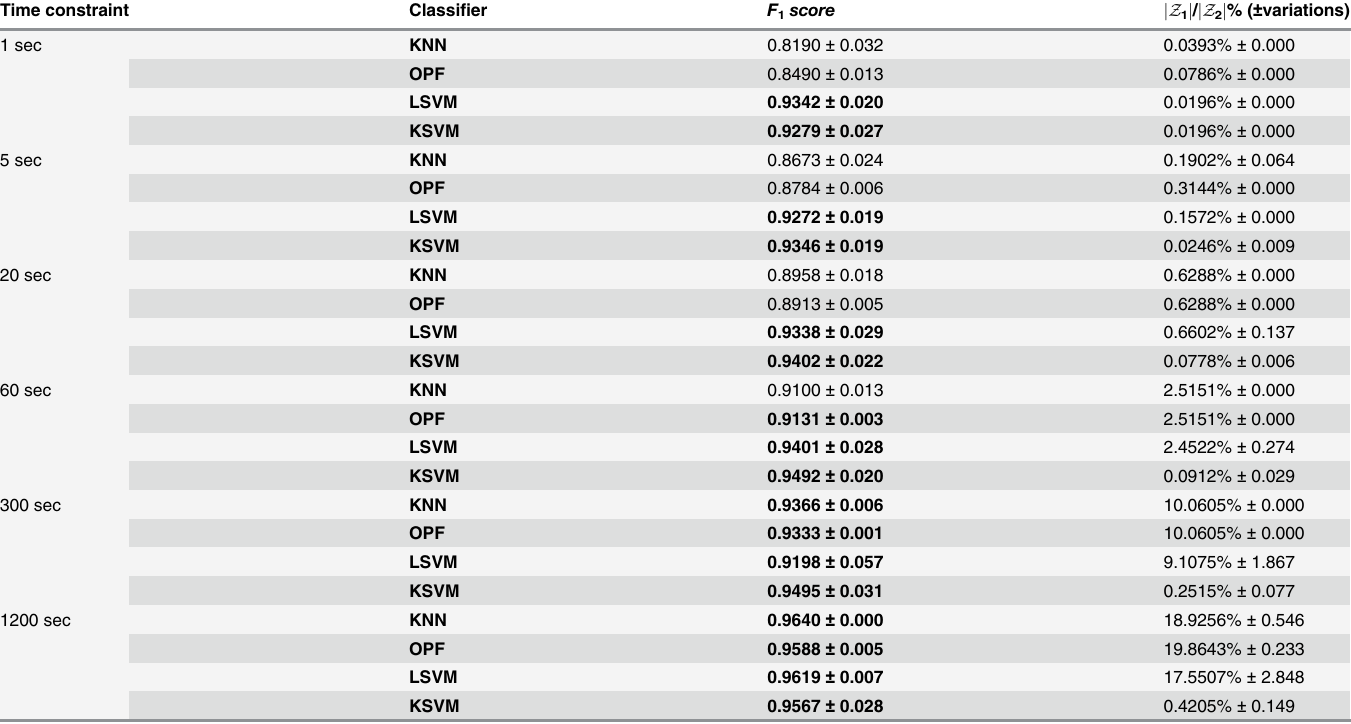
Table 2. Cod-RNA dataset: Predictivity performance over Z 3 and final training set size, j Z 1 j as a percentual of j Z 2 j , for each classification model and learning time constraint using the proposed selection.